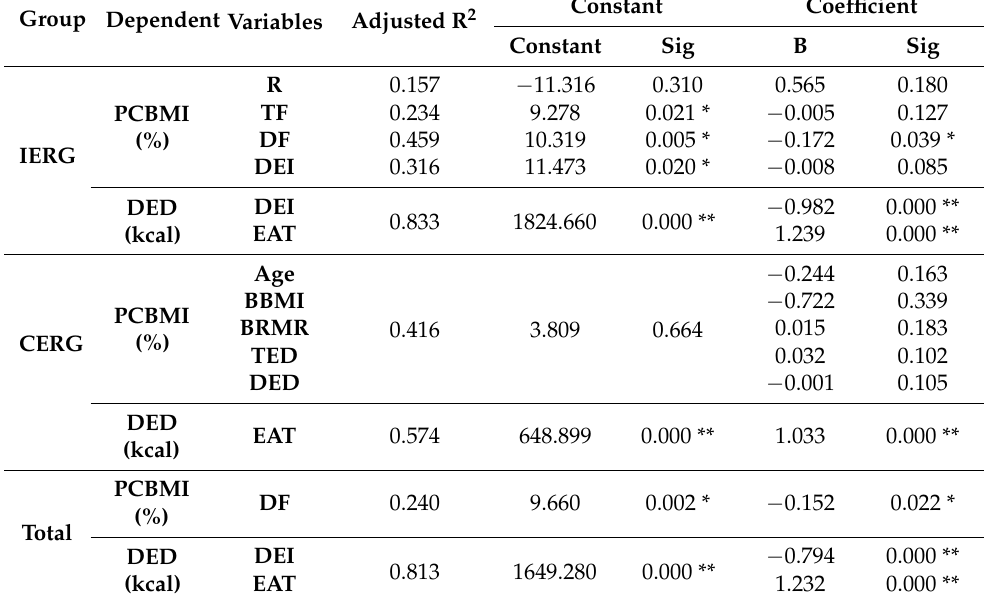
Table 8. The results of regression